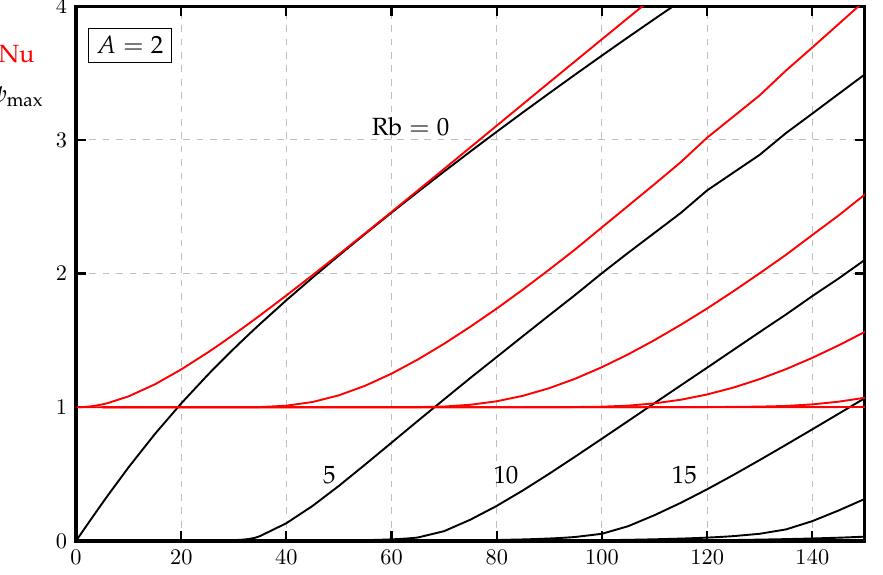
Figure 6. For an aspect ratio, A = 2, the variation with Ra of ψ max (black) and the Nusselt number, Nu (red) as Rb increases in steps of 5 from Rb = 0 to Rb = 25. Rb increases towards the right for ψ max and downwards for